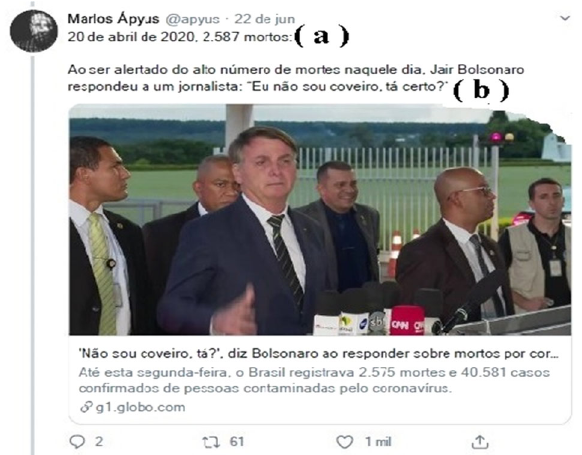
Fig. 7 Bolsonaro ’ s reaction, after being informed about the Covid-related deaths of locals. Translation (a): 20 April, 2020: 2587 deaths. Translation (b): When told about the large number of deaths on that day, Jair Bolsonaro replied to a journalist: “ I am not a grave-digger, okay? ”